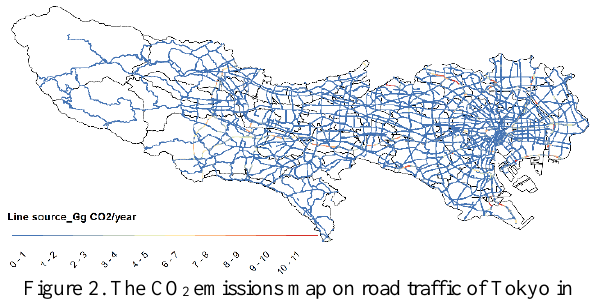
Figure 2. The CO 2 emissions map on road traffic of Tokyo in 2015, unit: Gg CO 2 yr -1